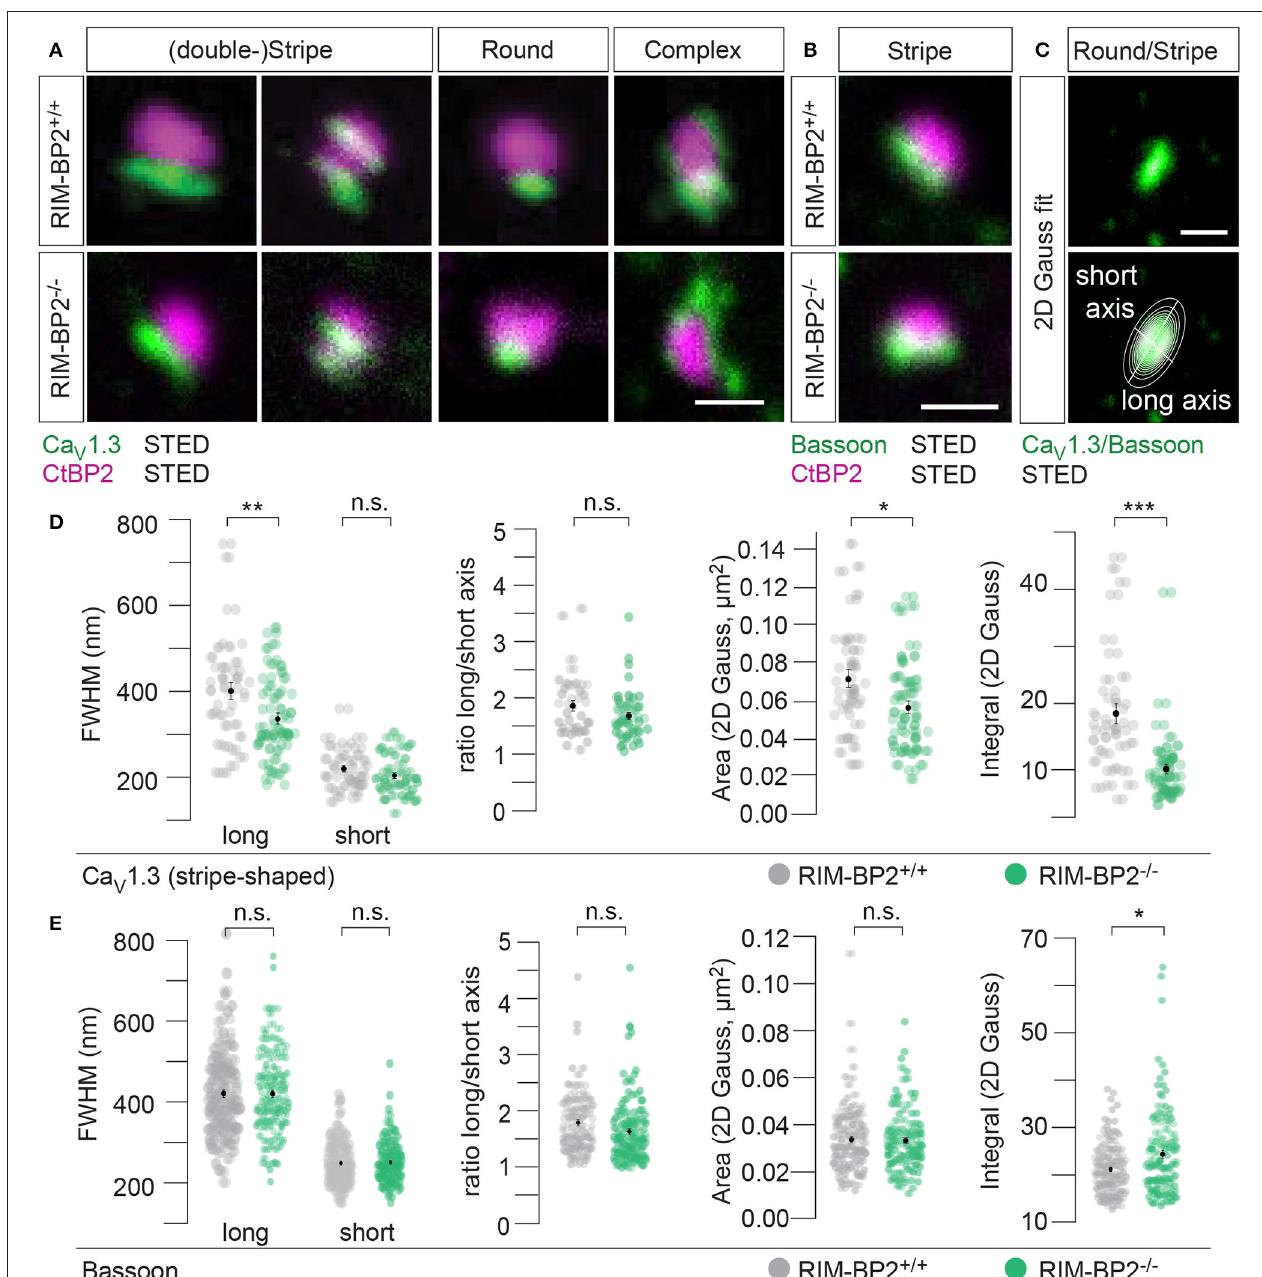
FIGURE 5 | RIM-BP2 promotes synaptic Ca 2 + -channel abundance at IHC ribbon synapses downstream of bassoon. (A,B) XY-sections of individual AZs acquired with high-resolution 2D 2-color STED microscopy. Whole-mount explants of apical RIM-BP2 + / + and RIM-BP2 − / − organs of Corti were immunolabeled for CtBP2/RIBEYE (magenta) and Ca V 1.3 (green, A ) or bassoon (green, B ). Scale bars: 500nm. (A) Ca V 1.3 clusters were subjectively classified in “(double-) stripe-like,” “round” and “complex” apparent shapes. (C) 2D Gaussian functions were fit to each individual STED image of “stripe-shaped” Ca V 1.3 and bassoon clusters to approximate the cluster dimensions. Fit amplitudes and FWHM of the long and short axis (illustrated) of the Gaussian function were used for quantitative analysis in (D,E) . Scale bar: 500nm. (D,E) Quantitative analysis of Ca V 1.3 (D) and bassoon (E) cluster STED images described in (C) . Data of FWHM long and short axis, the ratio of long over short axis, cluster area and integral are displayed as individual data points ( RIM-BP2 + / + in gray, RIM-BP2 − / − in green) and grand averages as mean ± SEM (black). (D) RIM-BP2 + / + n = 37, N = 2; RIM-BP2 − / − n = 49, N = 2. (E) RIM-BP2 + / + n = 127, N = 2; RIM-BP2 − / − n = 124, N = 2; (D,E) Mean ± SEM and statistical p -values are displayed in Table 2 . Significance levels: n.s. p ≥ 0.05, * p < 0.05, ** p < 0.01, *** p < 0.001; n = number of AZs, N = number of mice; age of mice: p21-p23.